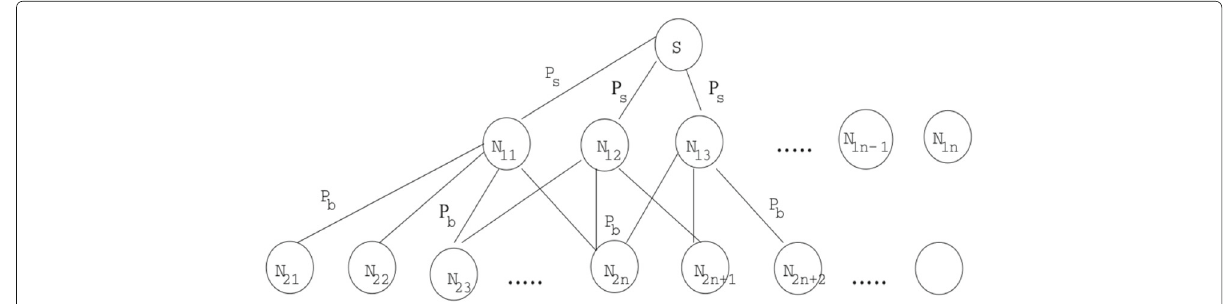
Fig. 5 First two retransmissions of flooding